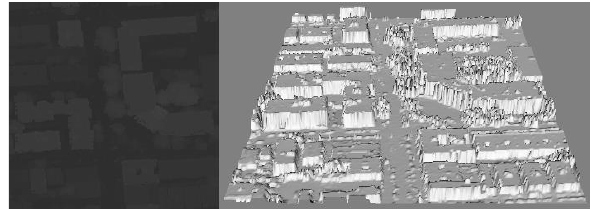
Figure 4. Proposed 3D cityscape reconstruction